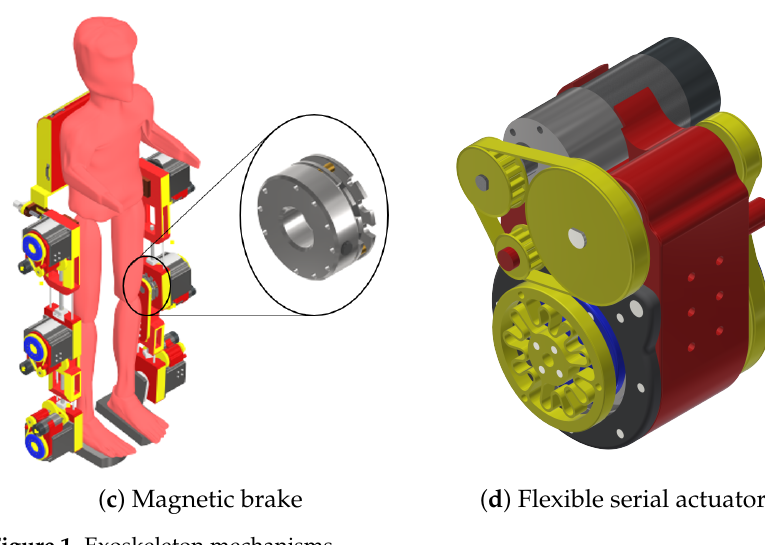
Figure 1. Exoskeleton mechanisms.